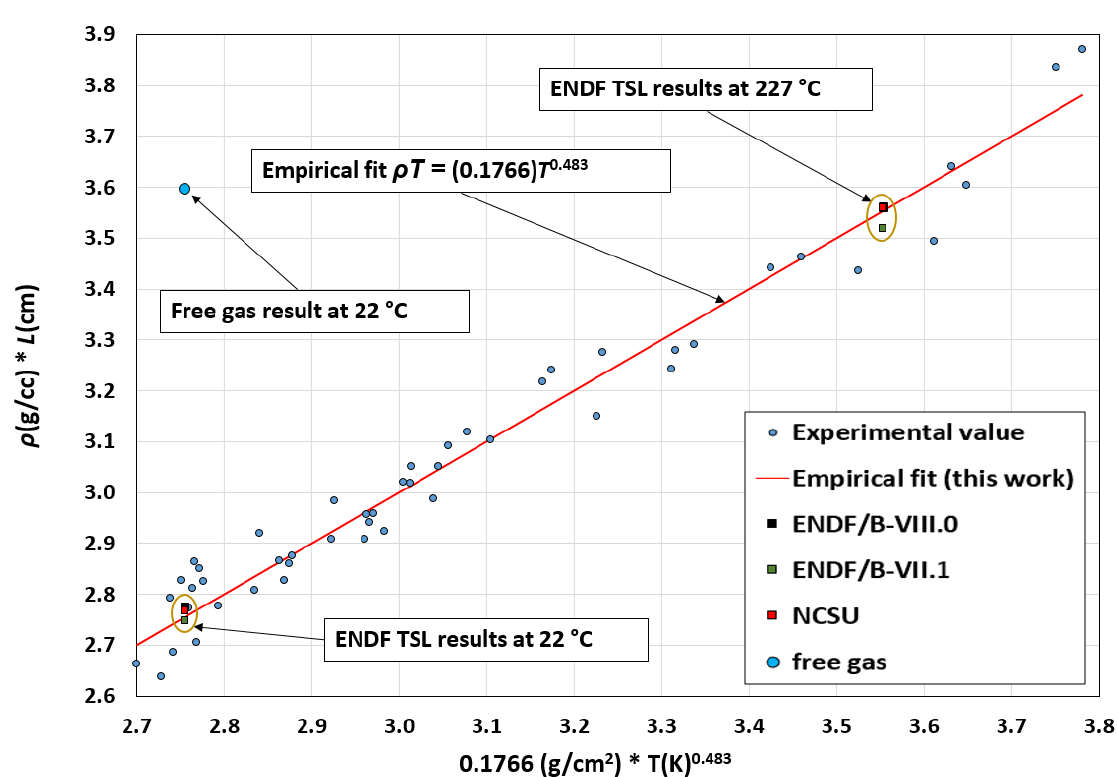
Figure 2. Comparison of MC21 Results to Experimental Data in Empirical Fit